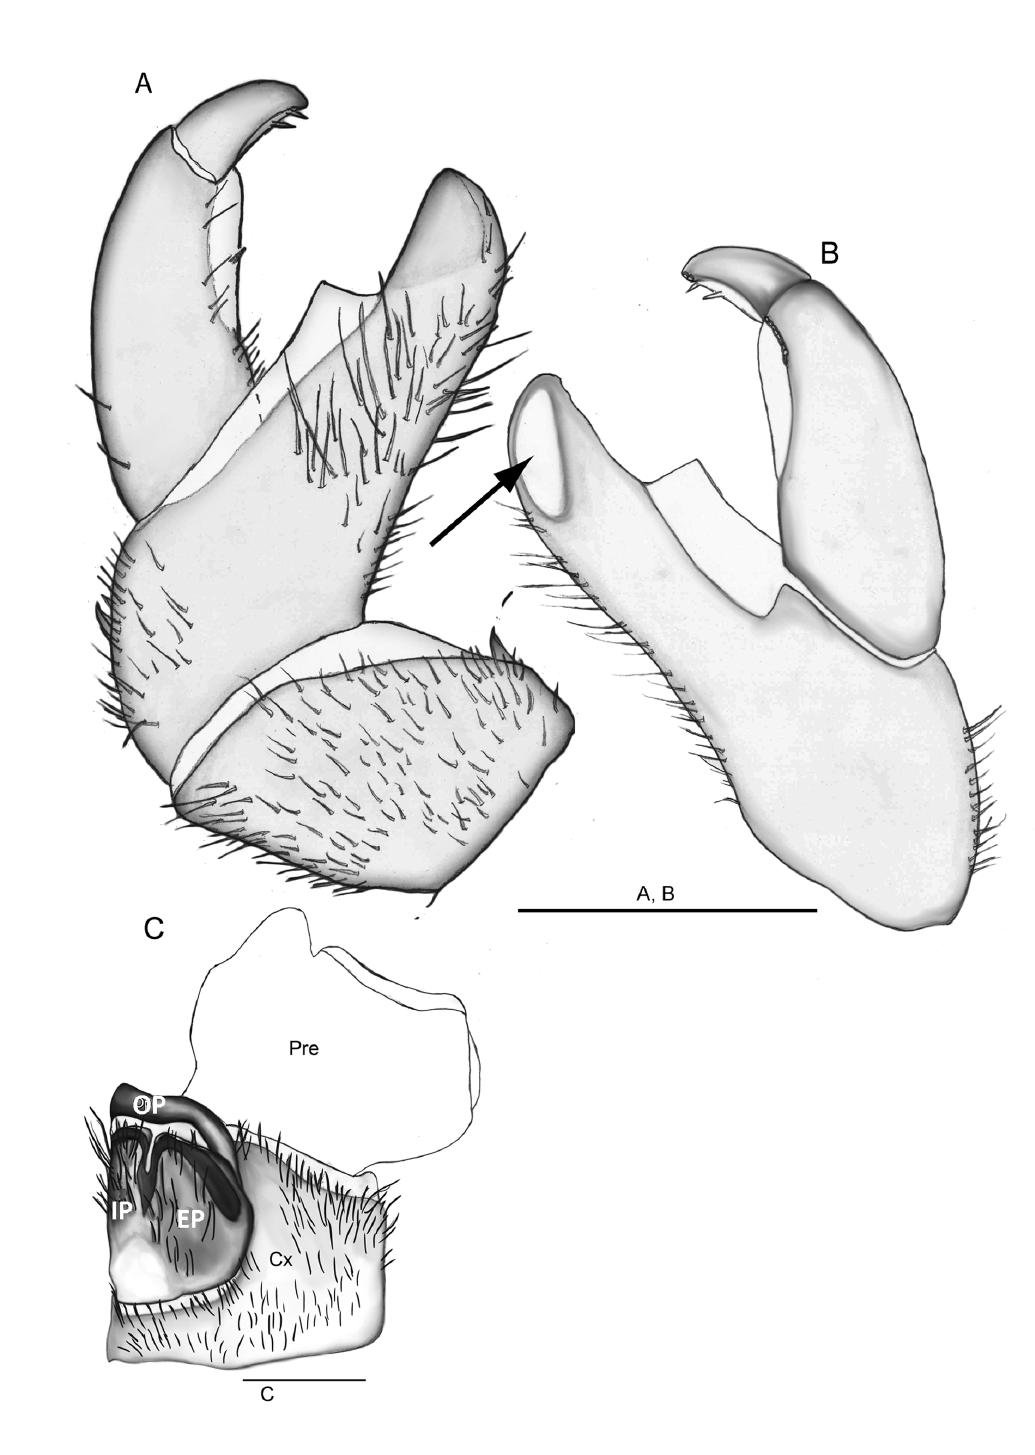
Fig. 5. Sphaerobelum aesculus Rosenmejer & Wesener sp. nov. drawings. A–B . Holotype, ♂ (NHMD 621693), C . ♀ (NHMD 621694). A . Left posterior telopod, anterior view. B . Left posterior telopod, posterior view, arrow points to swelling of immovable finger. C . Left second coxa and prefemur with female vulva. Abbreviations: Cx = coxa; EP = external, lateral plate; IP = inner, mesal plate; Op = operculum; Pre = prefemur. Scale bars = 1